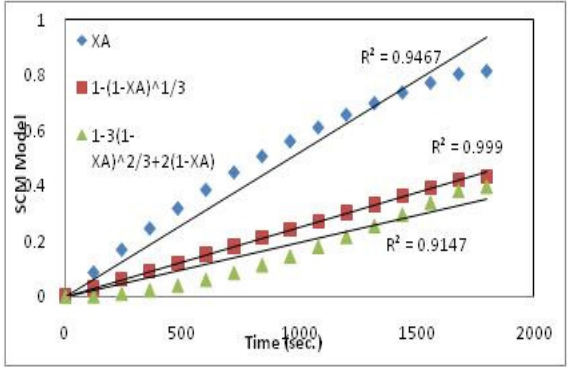
Fig. 6. Effect of reaction time on X A , 1-(1-X A ) 1/3 , 1- 3(1-X A ) 2/3 +2(1-X A